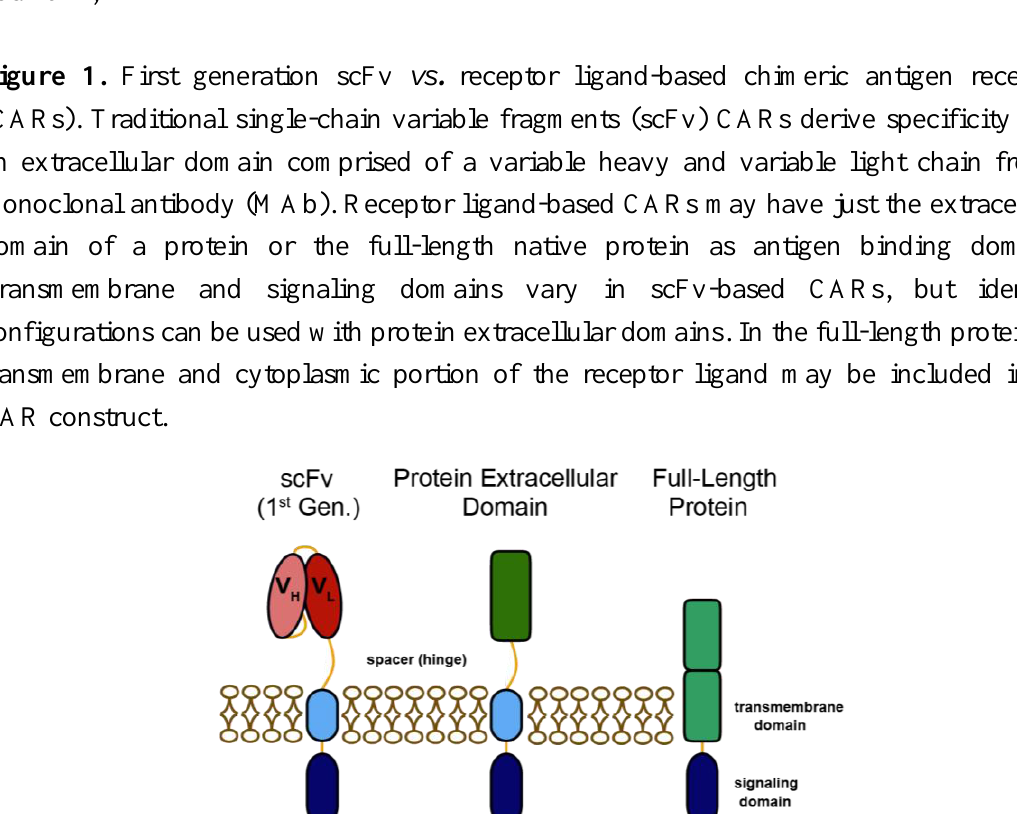
Figure 1. First generation scFv vs. receptor ligand-based chimeric antigen receptors (CARs). Traditional single-chain variable fragments (scFv) CARs derive specificity